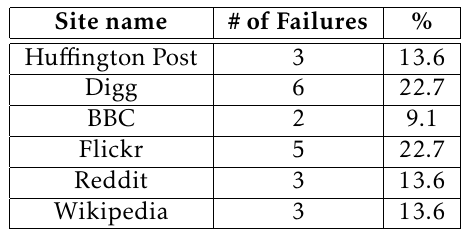
Table 6. Failures when retrieving a page with SPDY and a packet loss = 5% .